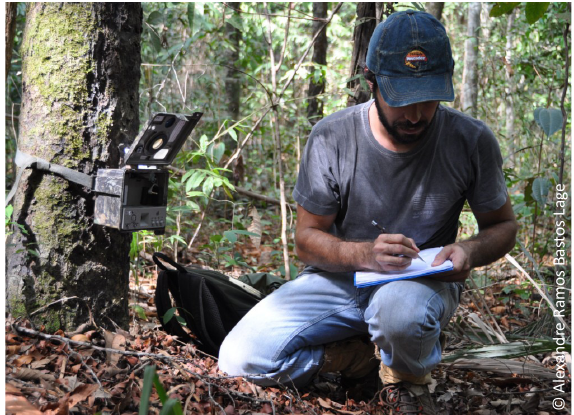
o s m p C a a i r qu e S i e li p F e ©